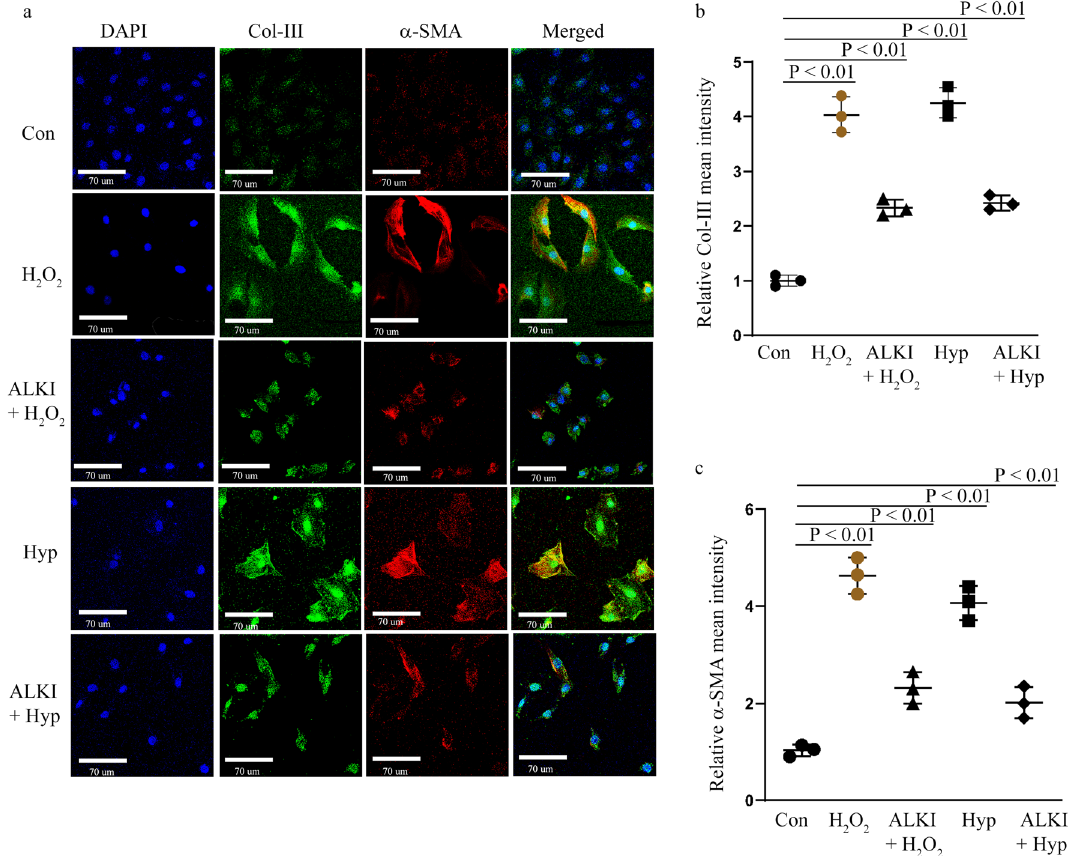
Figure 5. Inhibition of Col-III and α-SMA by ALKI pre-treatment. IF staining with anti-Col-III (shown in green) and anti-α-SMA (shown on red) antibodies showed inhibited expression of the markers under conditions of ALKI pre-treatment paired with H 2 O 2 and hypoxia when compared to only injury states-H 2 O 2 and hypoxia. Col-III expression reduced to 2.3 and 2.4 folds for ALKI + H 2 O 2 and ALKI + Hypoxia treatment sets from 4 and 4.25 folds for H 2 O 2 and Hyp treatments respectively ( a and b ). α-SMA levels were reduced to 2.3 and 2 folds for ALKI + H 2 O 2 and ALKI + Hypoxia treatment groups from 4.6 and 4 folds for H 2 O 2 and Hyp treatments respectively. DAPI (shown in blue was used as nuclear stain) n = 3, data analyzed and expressed as mean ± SD. Differences were considered statistically significant for p <